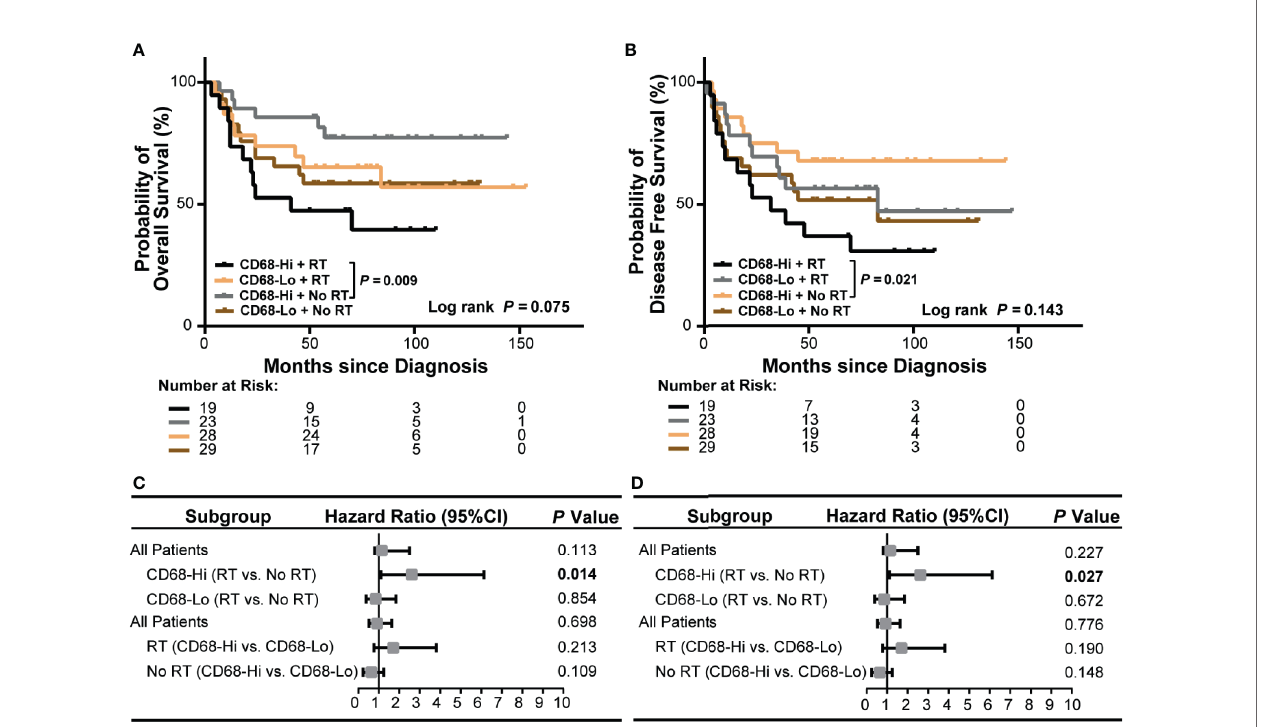
FIGURE 4 | Association of CD68 + macrophage in fi latration and radiation with survival of all OSCC patients in our cohort. (A, B) Kaplan-Meier curves show overall survival (A) and disease-free survival (B) in high or low level of CD68 + macrophage in fi ltrated OSCC patients receiving radiation or no radiation. Log-rank test and/or pair wised comparison was used for signi fi cance. (C, D) Forest plots illustrate hazard ratios of subgroup univariate cox regression of overall survival (C) and disease- free survival (D) . CD68-Hi, CD68-High; CD68-Lo, CD68-Low; RT, radiation.